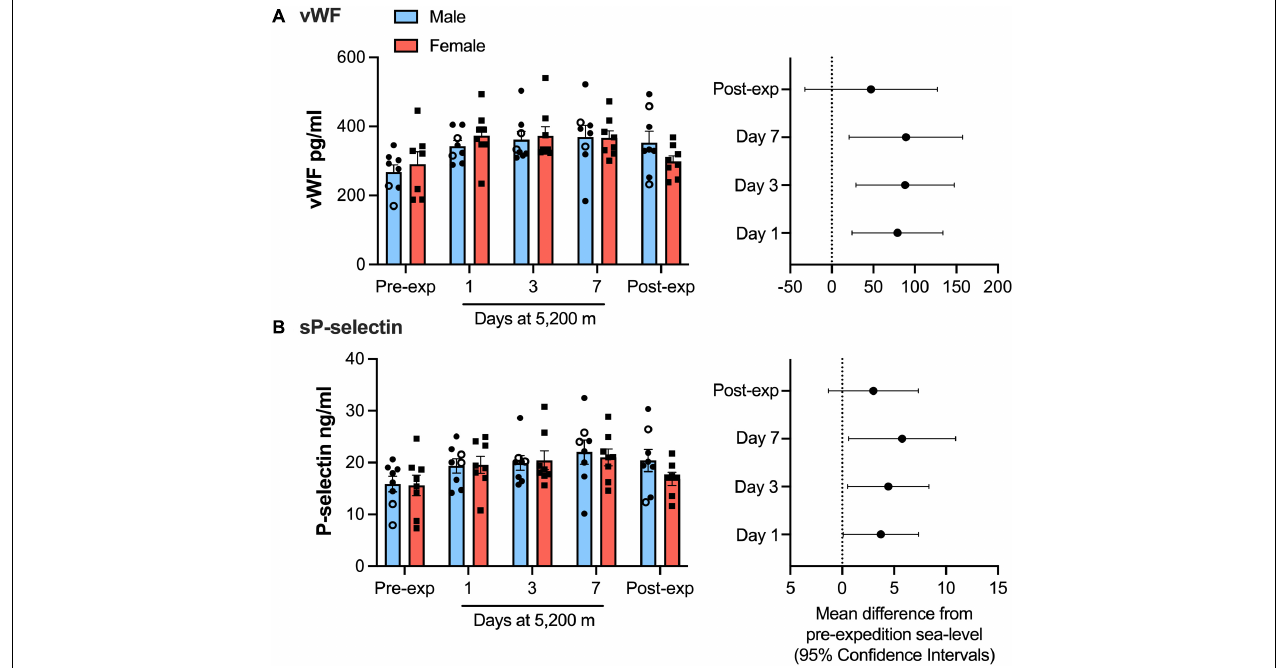
FIGURE 2 | von Willebrand factor (vWF) and P-selection plasma levels significantly increased during high-altitude induced hypoxia. Luminex immunoassay measurements demonstrate Plasma vWF (A) and soluble P-selection (B) levels at sea level and altitude split by sex. Left hand panels show mean data (top of bars) ± SEM with each individual value represented dots. Two smokers are indicated by open circles. Right hand pannels indicate mean difference from pre-expedition sea level with Confidence Intervals calculated by mixed model ANOVA and Dunnett’s multiple comparisons test n = 16.